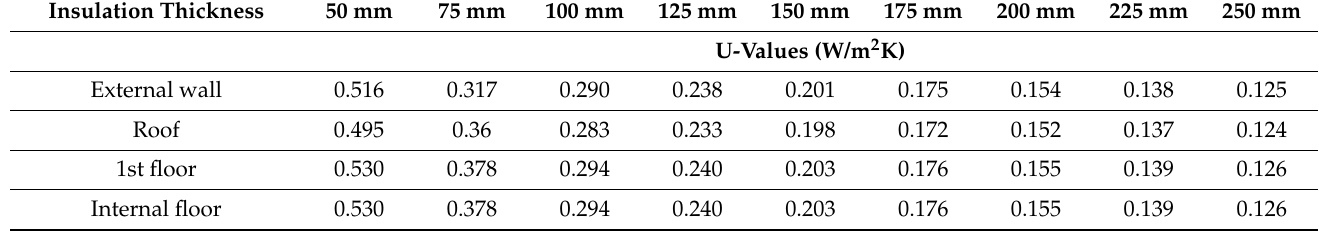
Table 2. Opaque components’ U-value (W/m 2 K) for different thicknesses of Rockwool insulation.